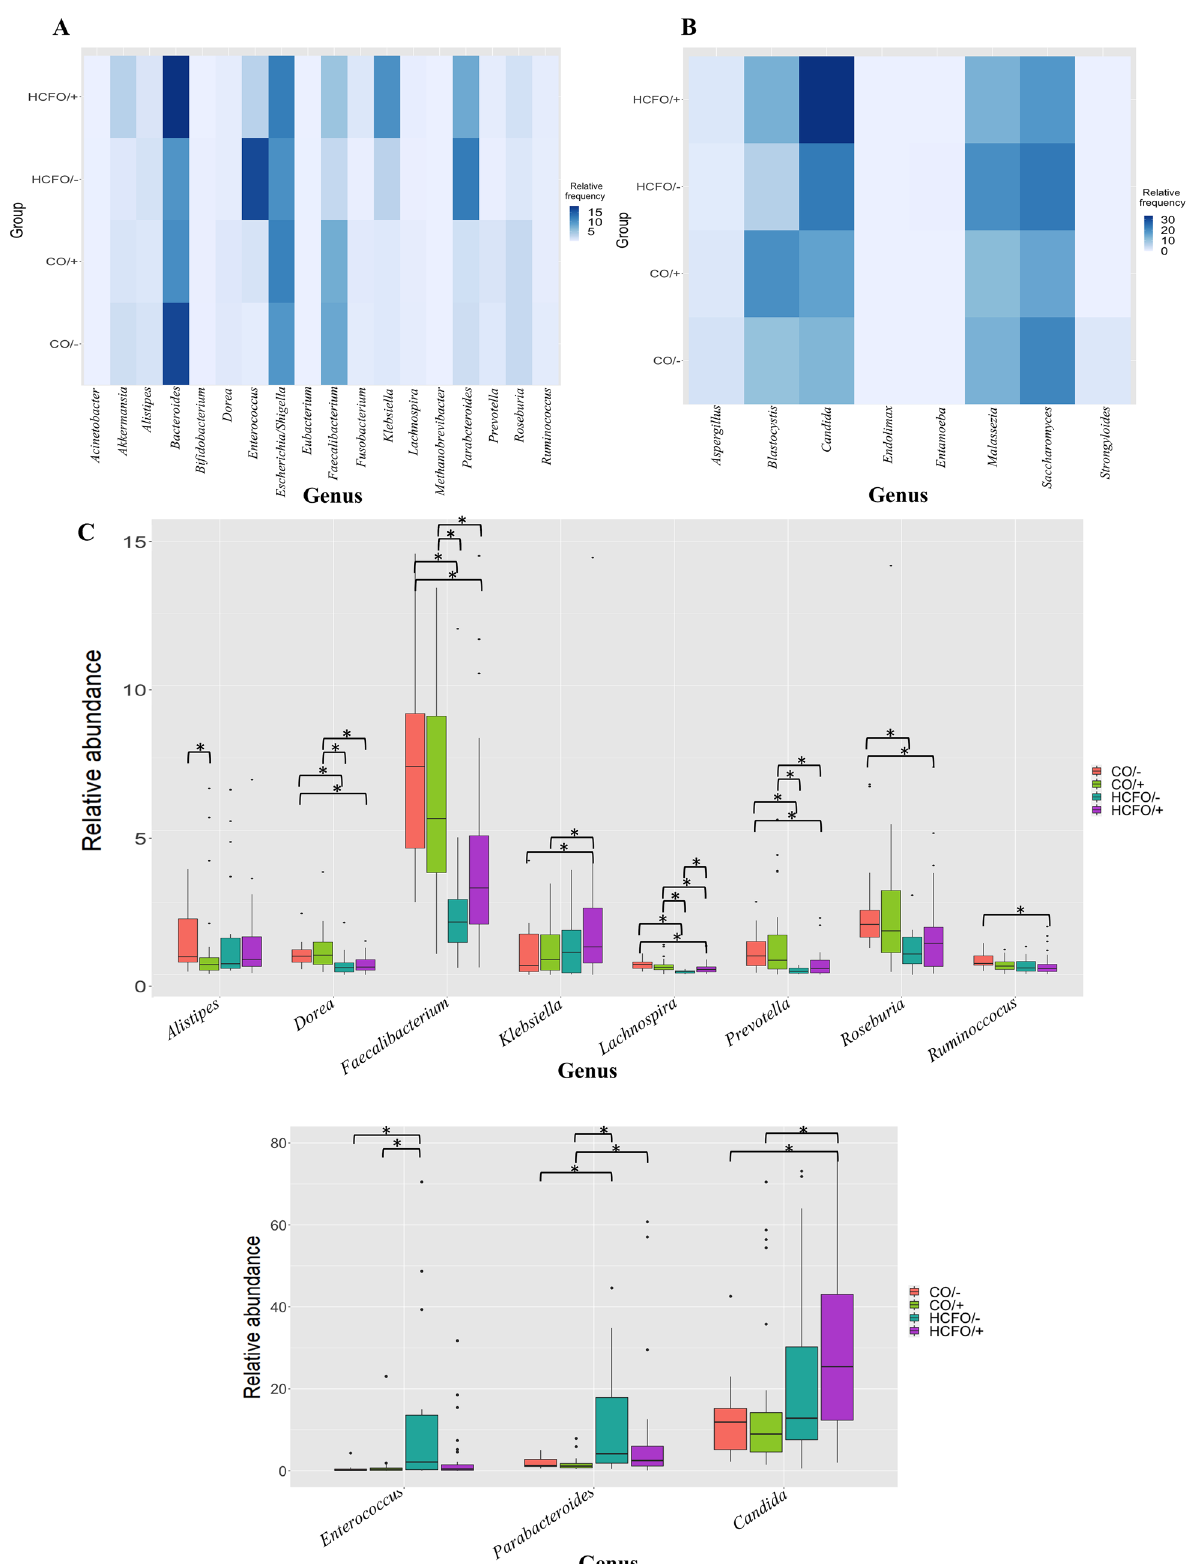
Figure 2. Changes in bacteria and eukaryotes commonly found in the gut microbiota. ( A ) Heatmap of bacterial genera by group. ( B ) Heatmap of eukaryotic genera by group. ( C ) Boxplot showing the differences between groups by relative abundances of each genus. Statistical differences (Kruskall–Wallis test; Post-hoc: Dunn test with Benjamini–Hochberg correction and a confidence level of 95%) ( p < 0.05) are indicated by an asterisk mark (*). Figure created on R studio with ggplot package 64,69